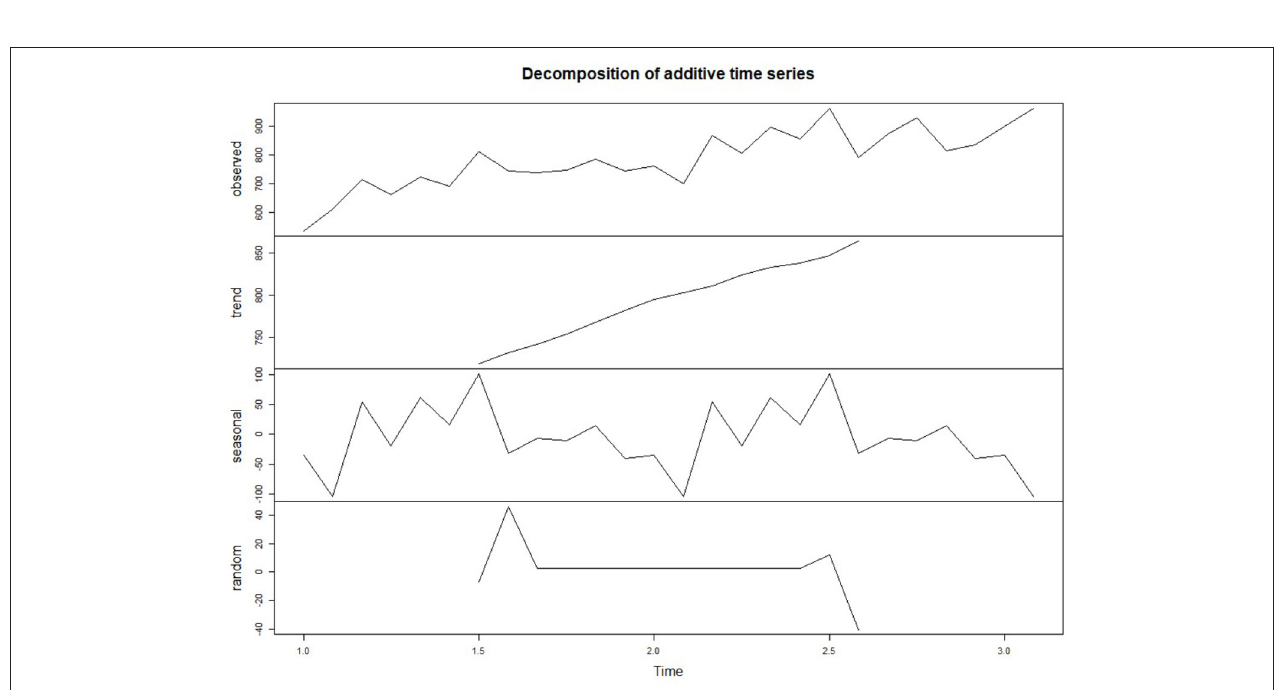
FIGURE 2 | Decomposed patient flow time series